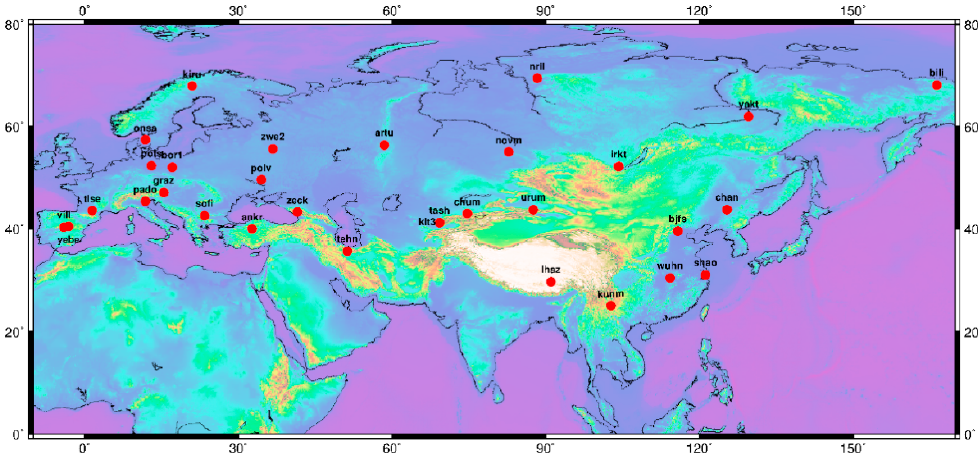
Figure 1. Spatial distribution of the 30 GPS stations used in this study.